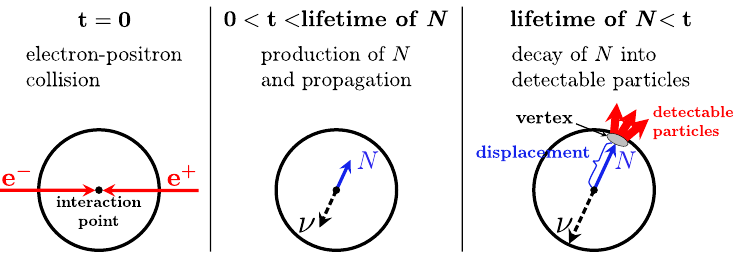
Figure 3 . Heavy neutrinos with long lifetimes yield the exotic signature of a displaced vertex, which is the visible displacement of the vertex from the interaction point. This signature allows to search for heavy neutrinos down to tiniest active-sterile